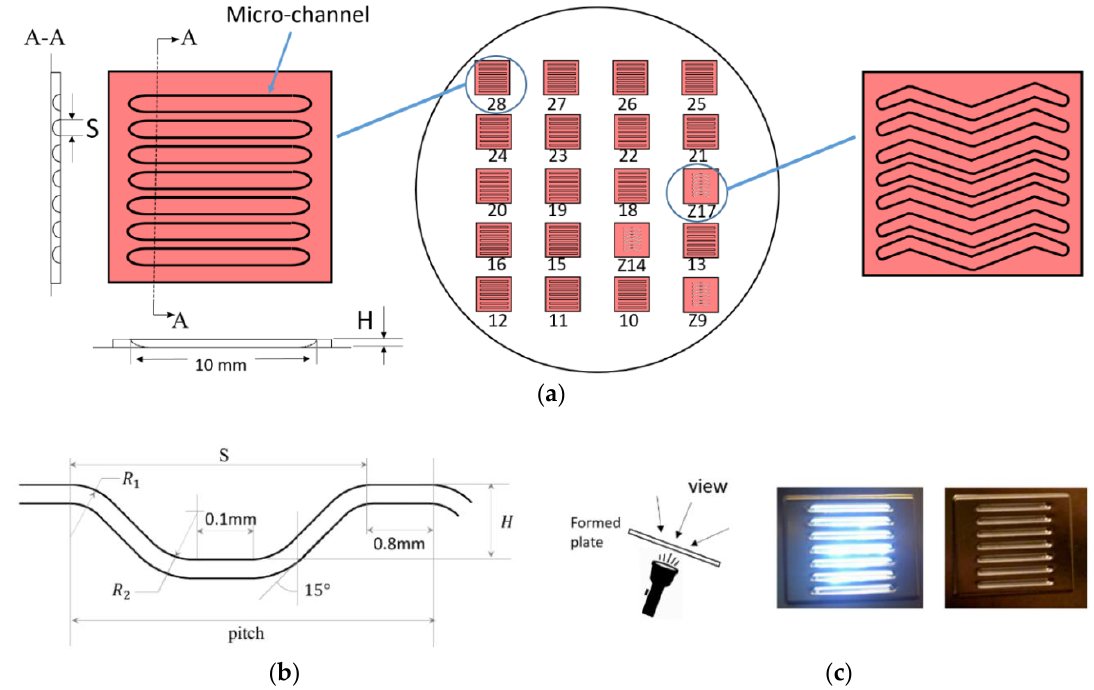
Figure 6. ( a ) Sample blank shape with micro-stamping patterns indicated. ( b ) Micro channel cross section parameters. ( c ) White light method used to determine material failure with a failed (left) and safe (right) example shown.